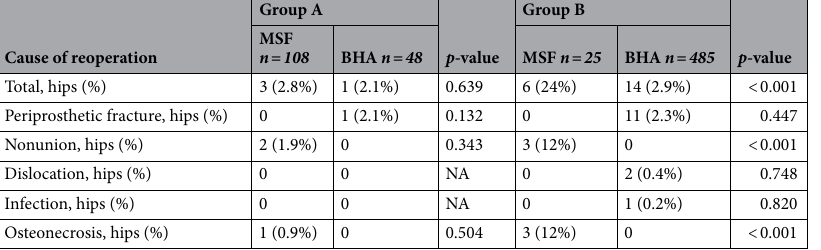
Table 3. Main causes of reoperation in patients with MSF and cementless BHA according to fracture type. MSF, multiple screw fixation; BHA, cementless bipolar hemiarthroplasty; n , numbers; NA, not